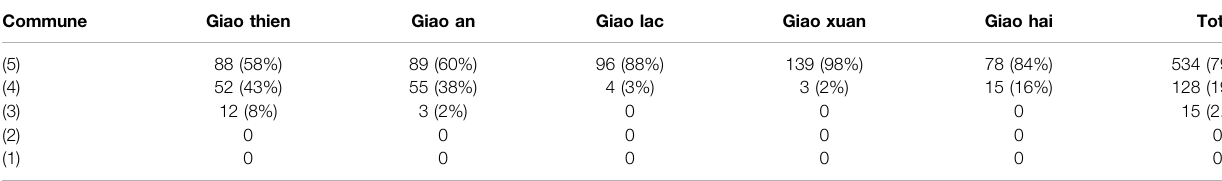
TABLE 5 | Respondents ’ opinion on wetland conservation at